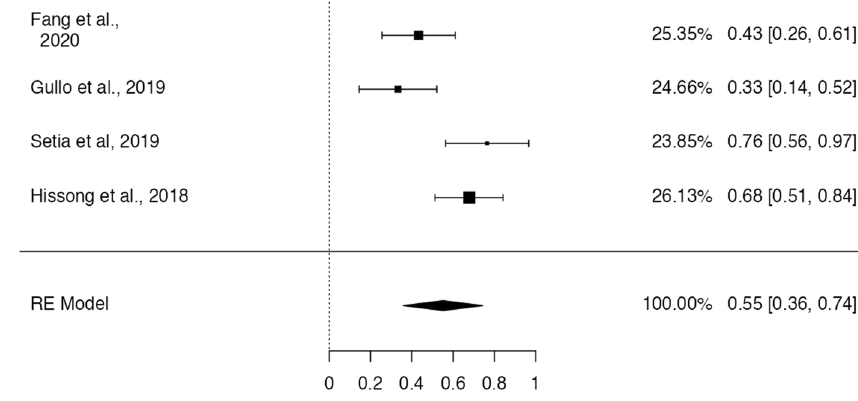
Fig. 11 Funnel-plot on the proportion of PD-L1 positivity rate on